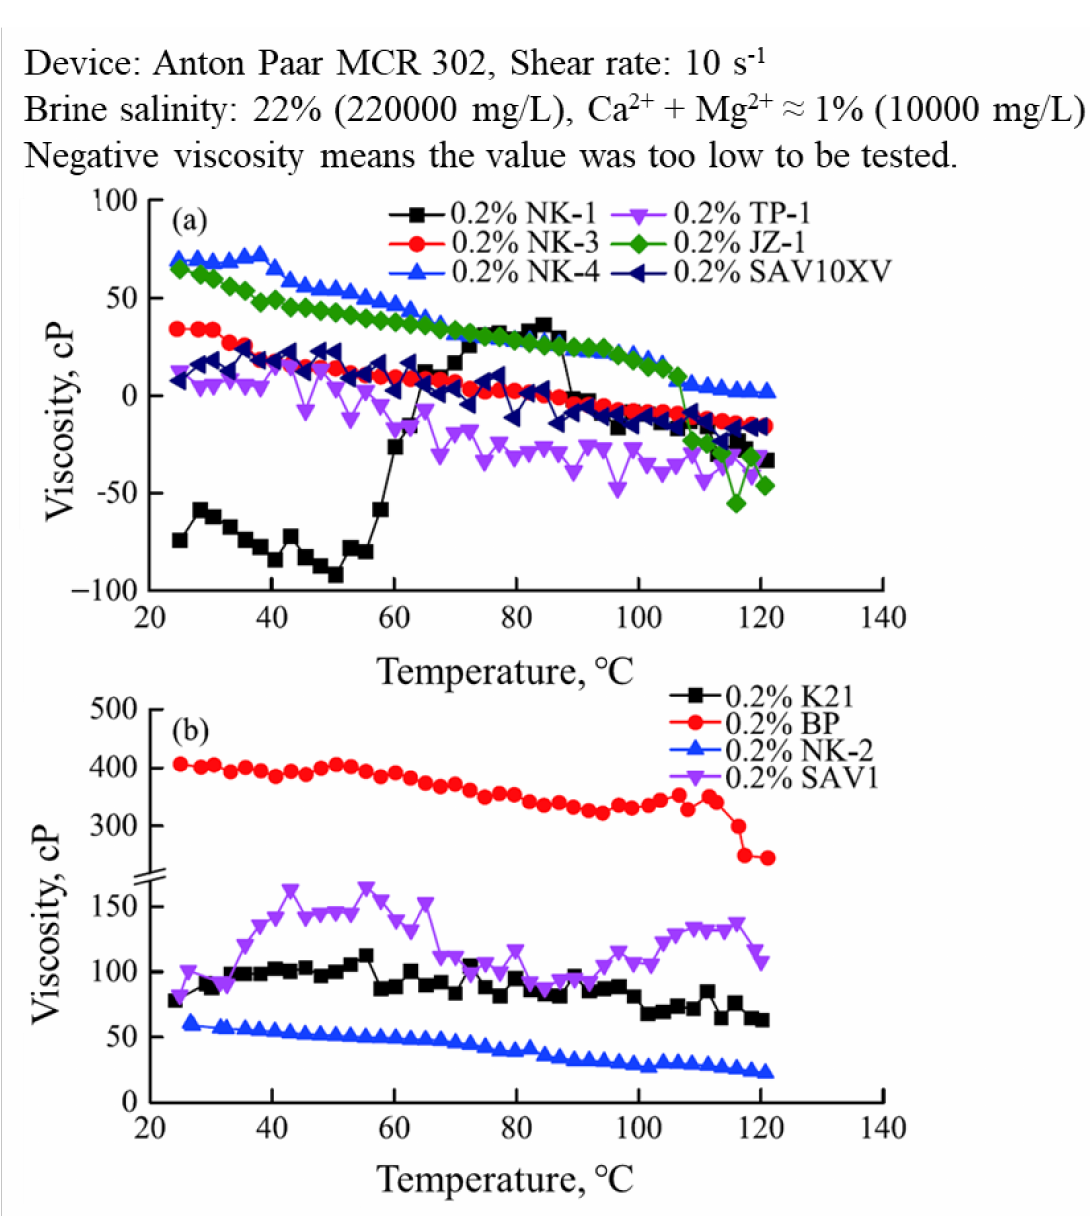
Figure 17. Polymers screened for high temperature and high salinity in Tahe oilfield (revised from